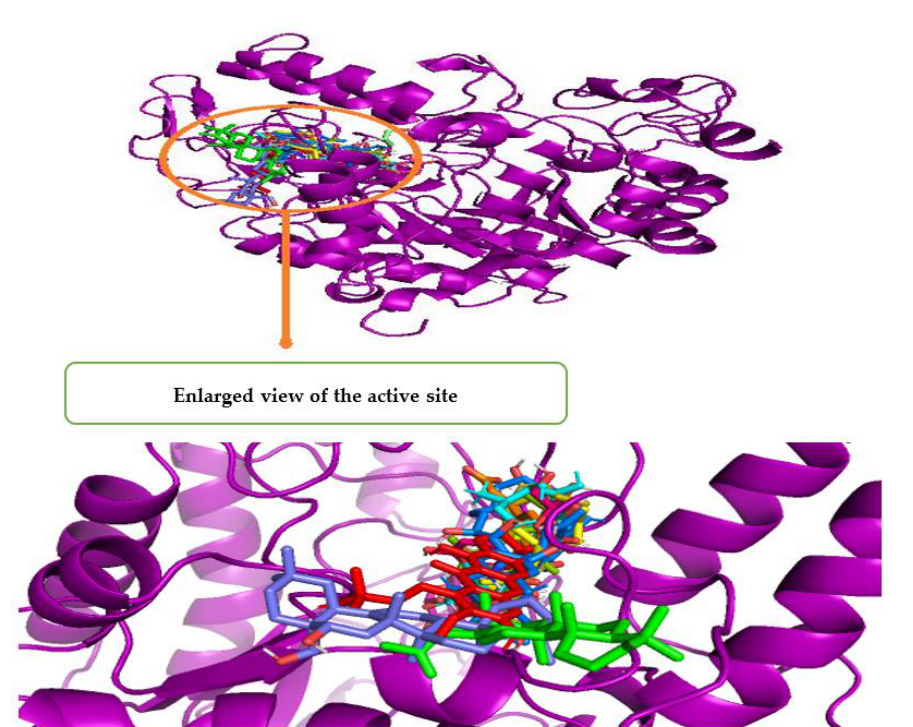
Figure 3. 3D superimposed diagram of the bioactive compounds ( m -coumaric acid, pantothenic acid, xestoaminol C, 2,3,4 ′ -trihydroxy-4-methoxybenzophenone, C16 sphinganine, swertianin, emmotin A, phytosphingosine, 1-monopalmitin, lupenone, 3-lsomangostin hydrate, swertianolin, 8- C -glucopyranosyleriodictylol, longispinogenin), quercetin and their binding site on the domain A of α -glucosidase enzyme (3A4A).